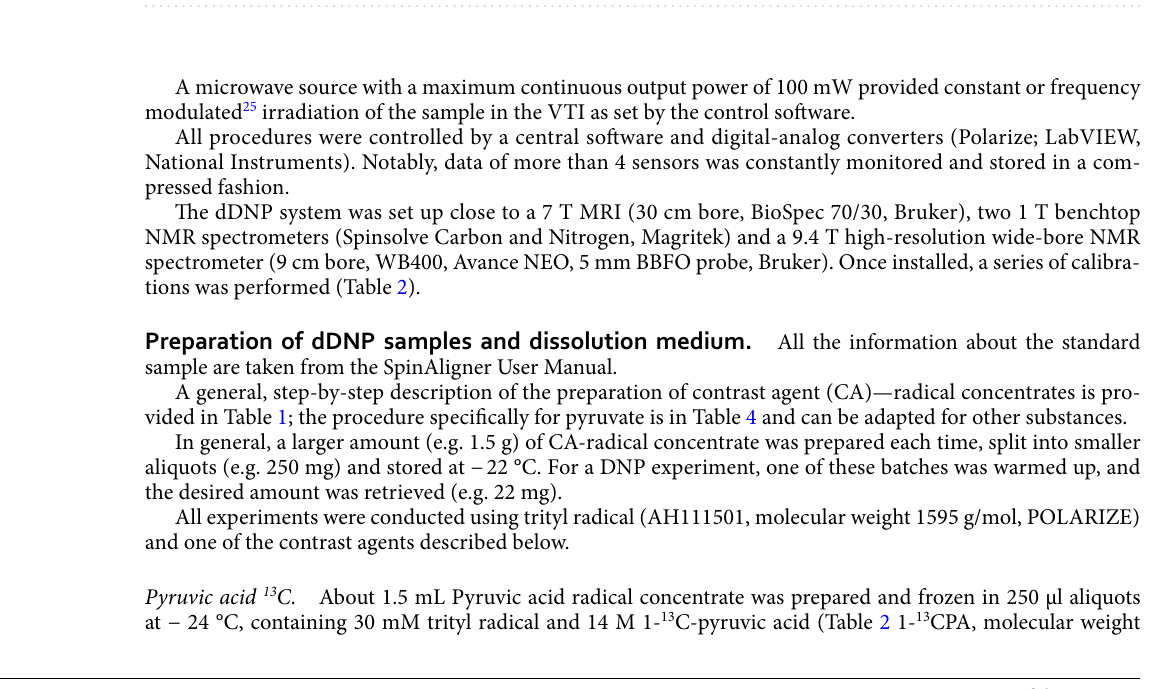
Table 1. General procedure to prepare contrast agent (CA) concentrates for